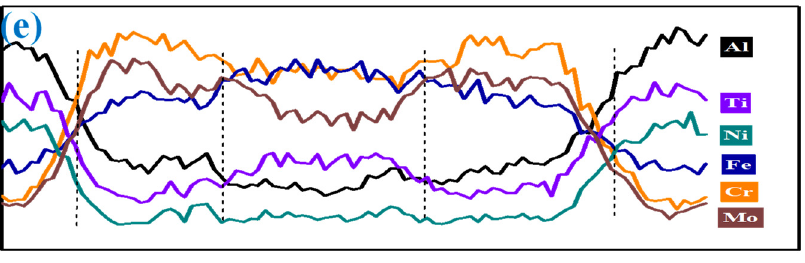
Figure 3. SEM backscattering electron micrographs of ( a , b ) AlCrFeNiTi 0.5 Mo 0.3 , ( c , d ) AlCrFeNiTi 0.5 Mo 0.4 HEAs. ( b , d ) Magnified images of the regions marked by yellow squares in images ( a , c ). ( e ) Line scans analysis of the interface between brightest precipitate and adjacent BCC phase in AlCrFeNiTi 0.5 Mo 0.4 HEA shown in ( d ).